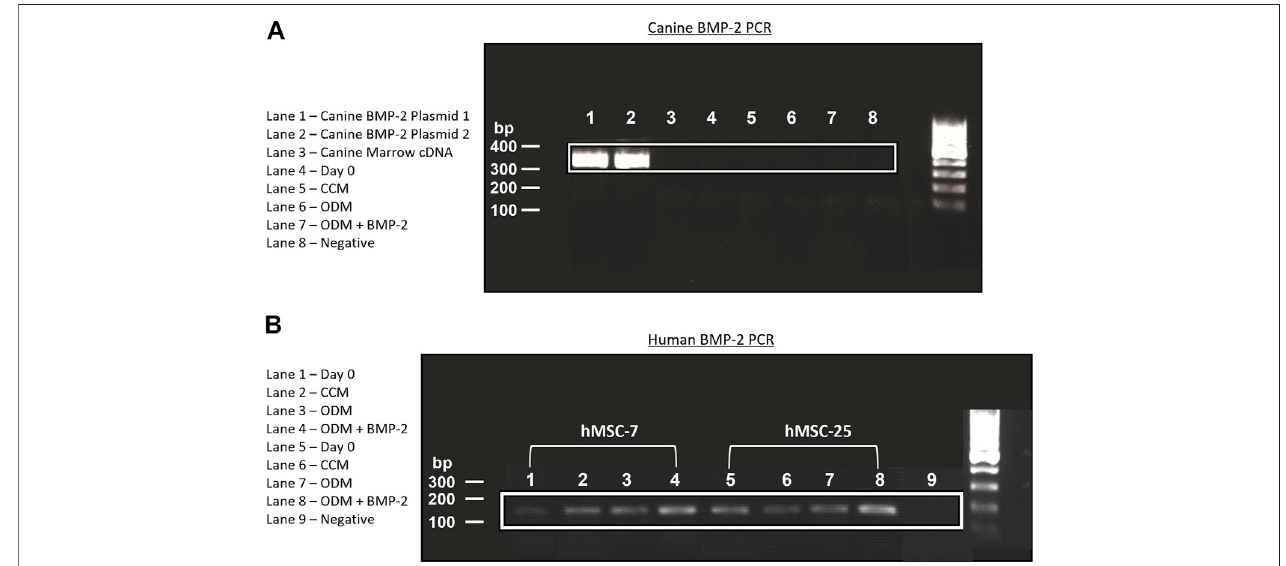
FIGURE 7 | Endogenous expression of canine and human BMP-2 by RT-PCR. (A) : A plasmid encoding the canine BMP-2 gene was acquired and two preparationsofthisplasmid cDNAwereused forpositivecontrols(Lanes1,2).RNAfromcaninebonemarrow,orRNAsamplesobtainedfromcMSCs atDay0orDay7 of the ALP activity assay ( Figure 6 ) were used to create cDNA. All cDNA samples were assessed for canine BMP-2 gene expression using a primer pair designed to createa324 bptranscript.TherewasrobustexpressionofthecanineBMP-2geneinthecontrolplasmids(Lanes1and2).CaninebonemarrowandcMSCsatDay 0 and Day 7 of the ALP activity assay did not exhibit detectible canine BMP-2 gene expression. (B) : RNA from the two preparations of hMSCs in Figure 6 were used to create cDNA. Expression of human BMP-2 was evaluated in both preparations of hMSCs at Day 0 and Day 7 (CCM, ODM, and ODM + BMP-2) with a primer pair designed to create a 188 bp transcript. Human BMP-2 was present at both timepoints and in all conditions. There was an increase in BMP-2 signal in the samples isolated from Day 7 of the ALP activity assay, particularly in the cells treated with ODM + BMP-2. These fi ndings are supportive of the results provided in Figure 6 and demonstrate clear differences in endogenous BMP-2 gene expression of canine and human MSCs in response to osteogenic induction media.